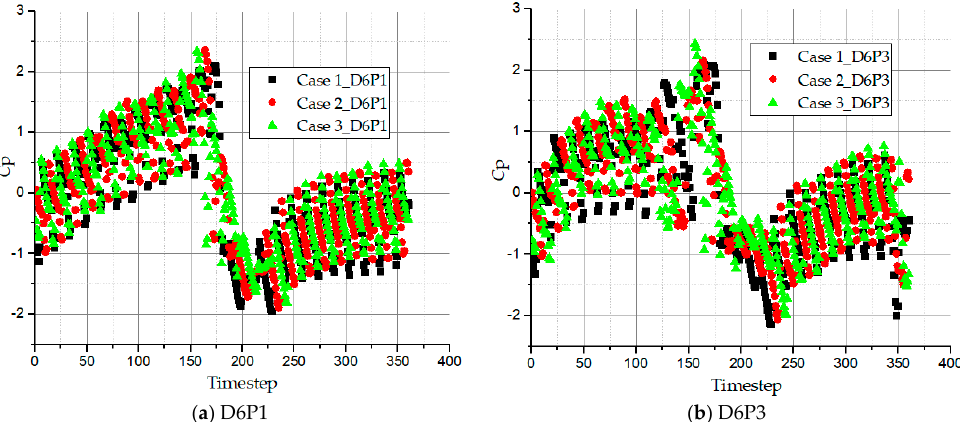
Figure 13. Time domain history of pressure fluctuation in impeller passage at 180° offset region for all pump cases.